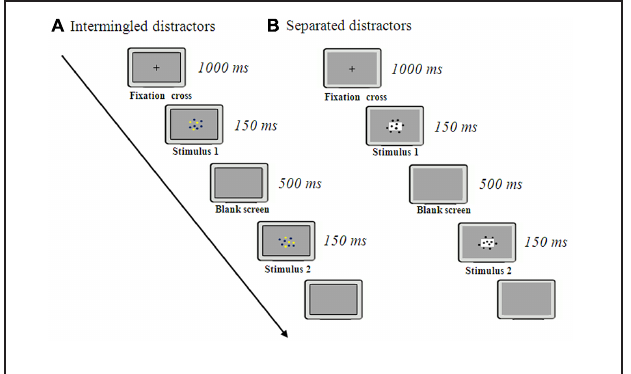
FIGURE 6 | Procedure of Experiment 4. Participants were required to estimate the larger group when other distractors were simultaneously presented separately (B) or mixed together (A) to the target stimuli.